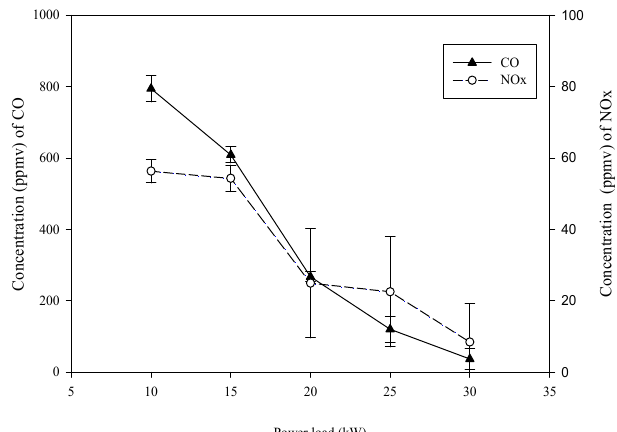
Figure 3. Un-adjusted concentrations of the exhaust of CO and NOx from micro gas turbine electricity generator using biogas for test operation. Exhaust gas T avg = 275 °C.